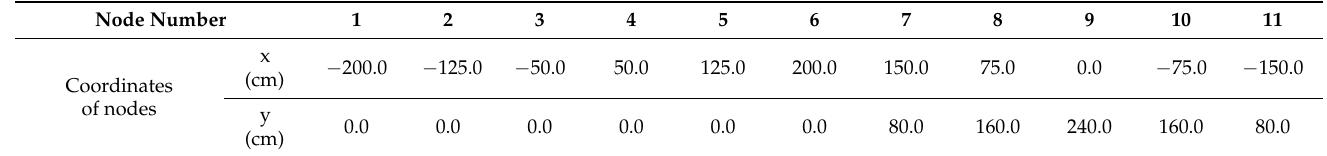
Table 3. Coordinates of the nodes.